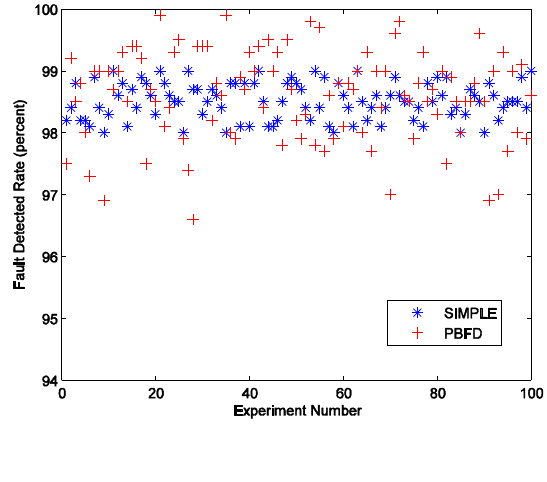
Figure 6. The fault detection rate of different